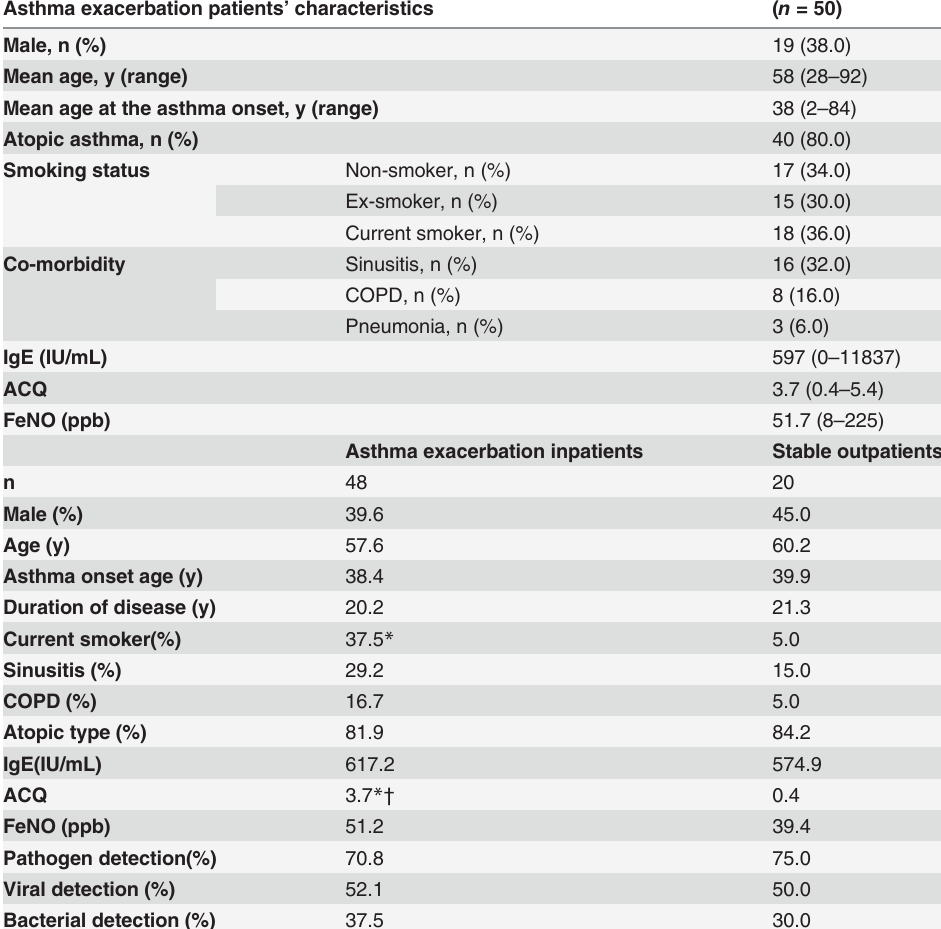
Table 1. Patients ’ characteristics. Asthma exacerbation patients ’